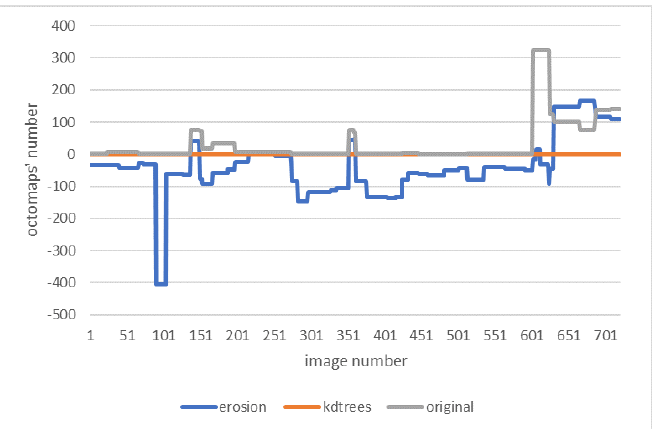
Figure 9. Differences of erosion and original with the proposed